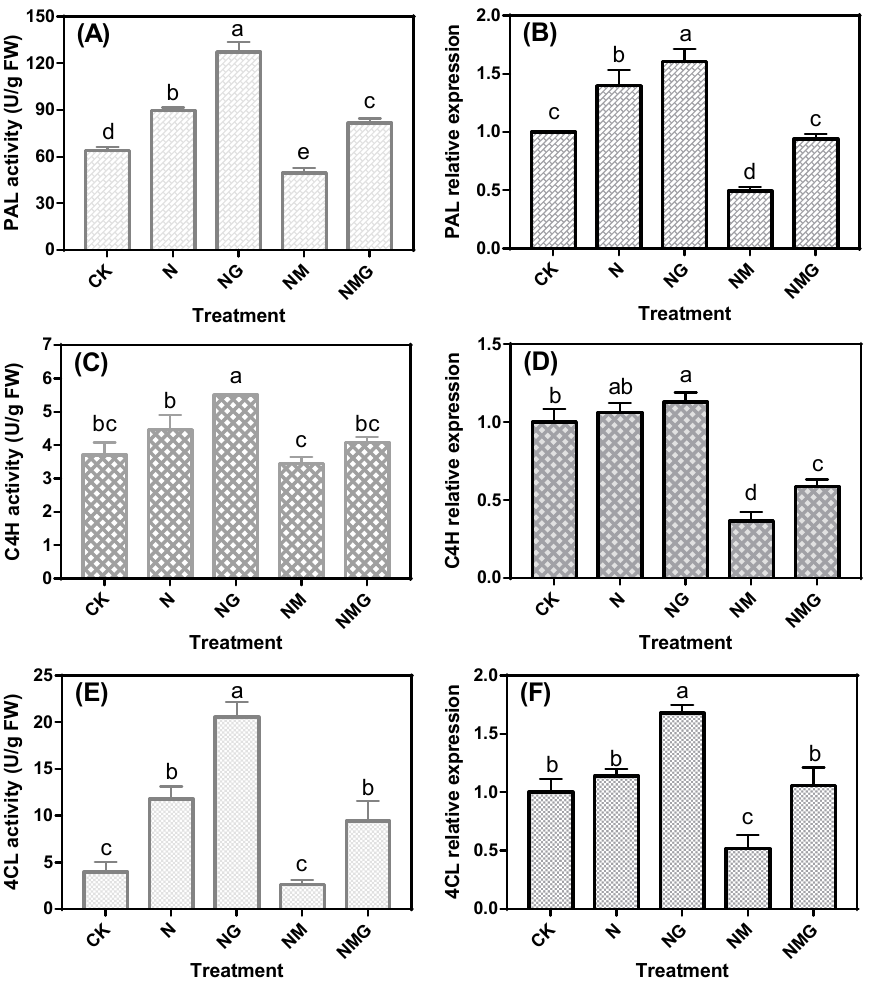
Figure 2. Effects of GABA treatment on phenylalanine ammonia lyase (PAL; A ), cinnamic acid 4-hydroxylase (C4H; C ), 4-coumarate coenzyme A ligase (4CL; E ) activity and their mRNA lev- els ( B , D,F ) in soybean sprouts under NaCl stress ( n = 3). CK, N, NG, NM, and NMG indi- cate distilled water treatment, 40 mM NaCl treatment, 40 mM NaCl + 5 mM GABA treatment, 40 mM NaCl + 0.2 mM 3-MP treatment, and 40 mM NaCl + 0.2 mM 3-MP + 5 mM GABA treatment, respectively. Error bars represent standard deviation. Values in the same measured category bearing different letters (a–e) are significantly different ( p <